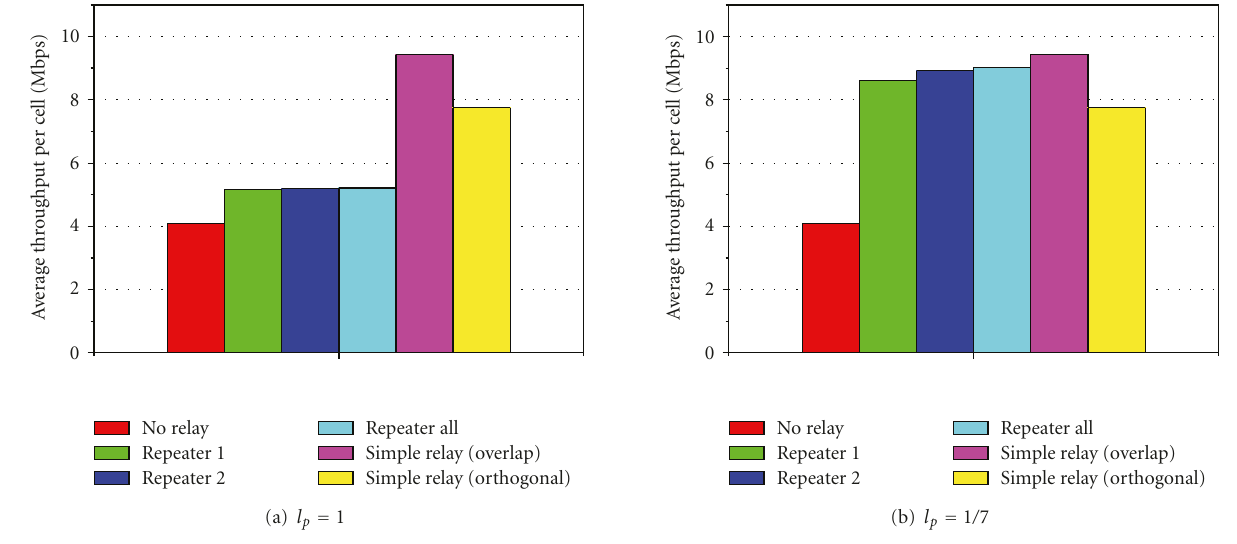
Figure 6: Comparison of average system throughput.